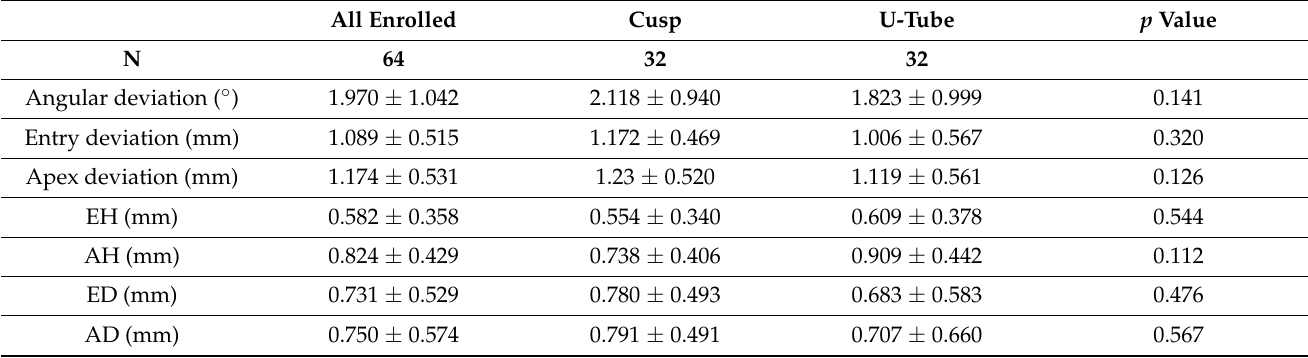
Table 1. Descriptive and bivariate results of the main outcome variables for both groups.